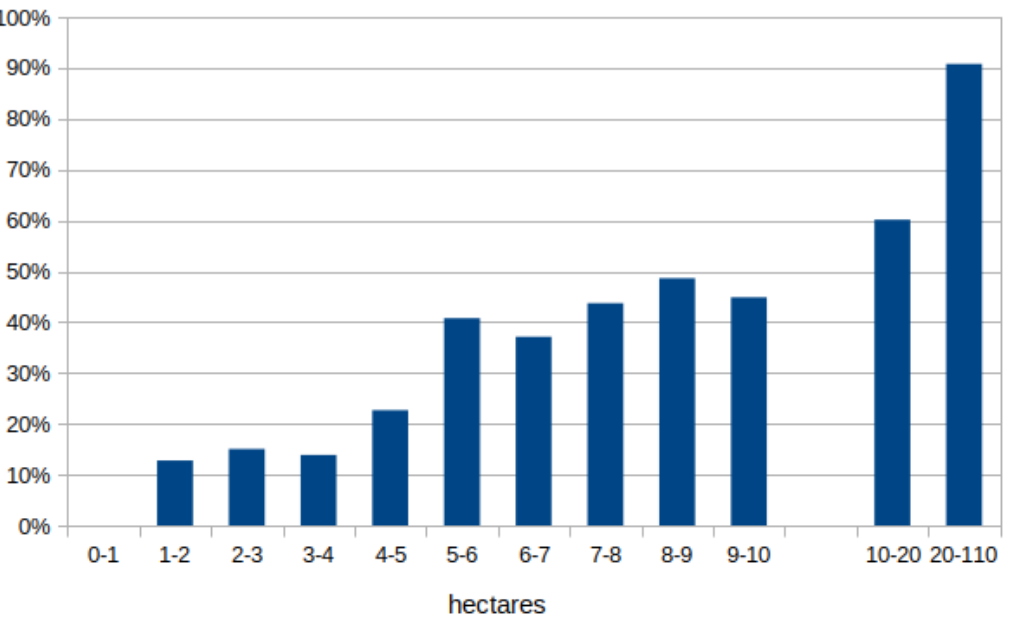
Figure 5. Mean number of failed certification attempts, in relation to the farm size in hectares.